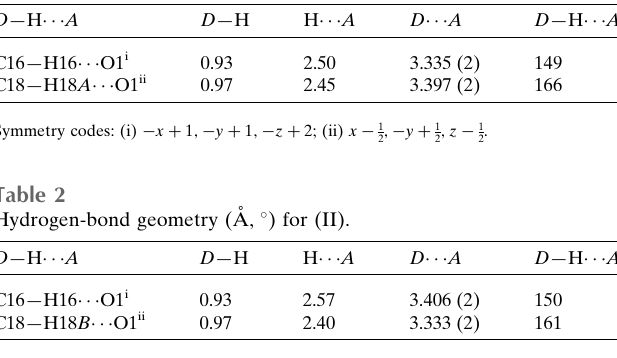
Table 1 Hydrogen-bond geometry (A˚ , (cid:3) ) for (I).